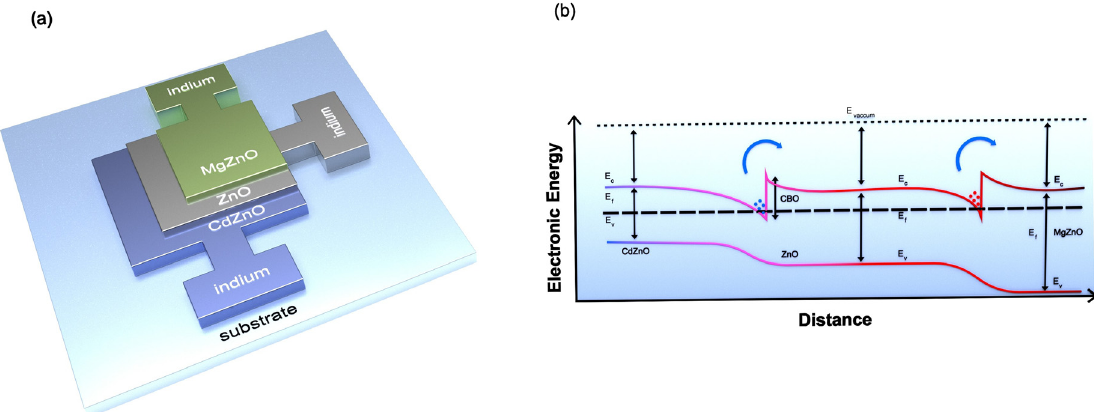
Figure 1: (a) Schematic of the proposed nanophotonic device for wavelength detection. Active layers CdZnO – ZnO – MgZnO forming two heterojunctions at the interface of CdZnO – ZnO and ZnO – MgZnO along with individual contact pads enabling application of bias voltage. (b) Electronic band diagram of the double heterojunction along with confined charge carriers. Horizontal axis represents distance from the substrate along the thickness of the deposited layers and vertical axis represents the electronic energy. Conduction band offset at both the junctions are 0.54 and 0.56